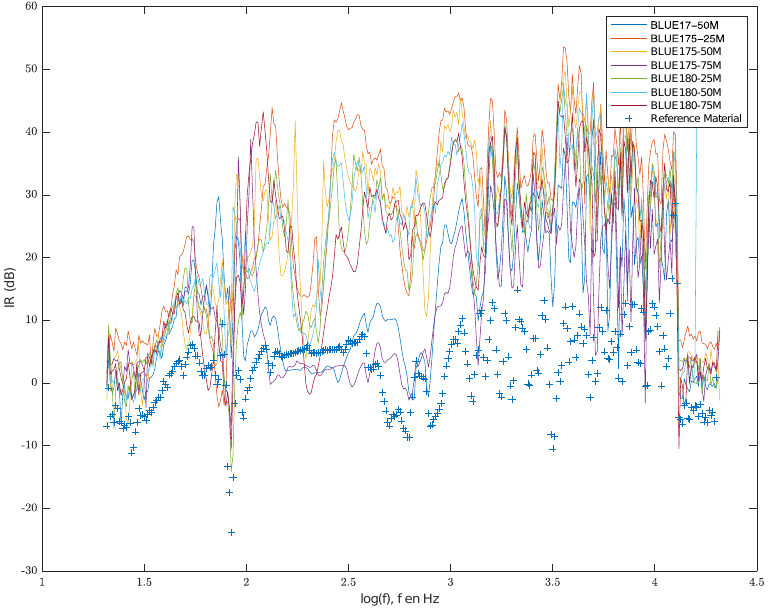
Figure 8. Reduction index of blue briquettes (lines) compared to the reference material (crosses). Volume 6.